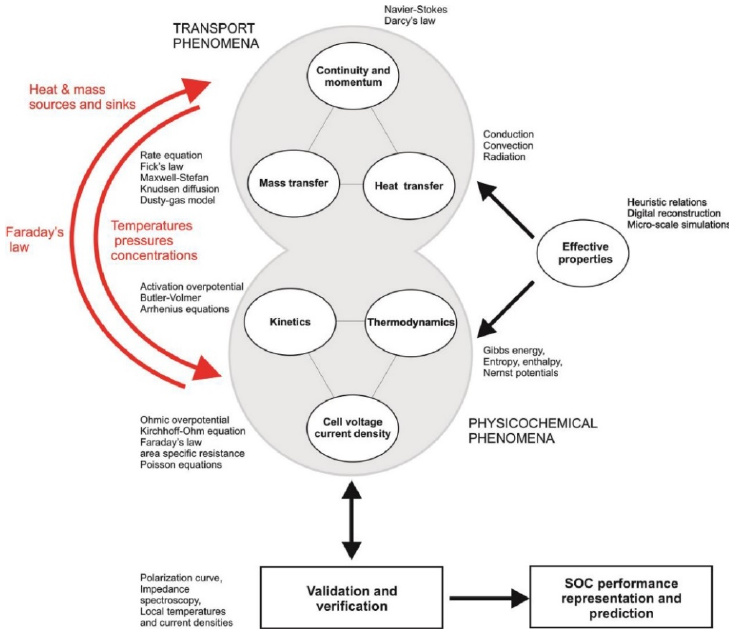
Figure 1. Modelling items in SOFCs. Reproduced from [5] under the Creative Commons Licence.